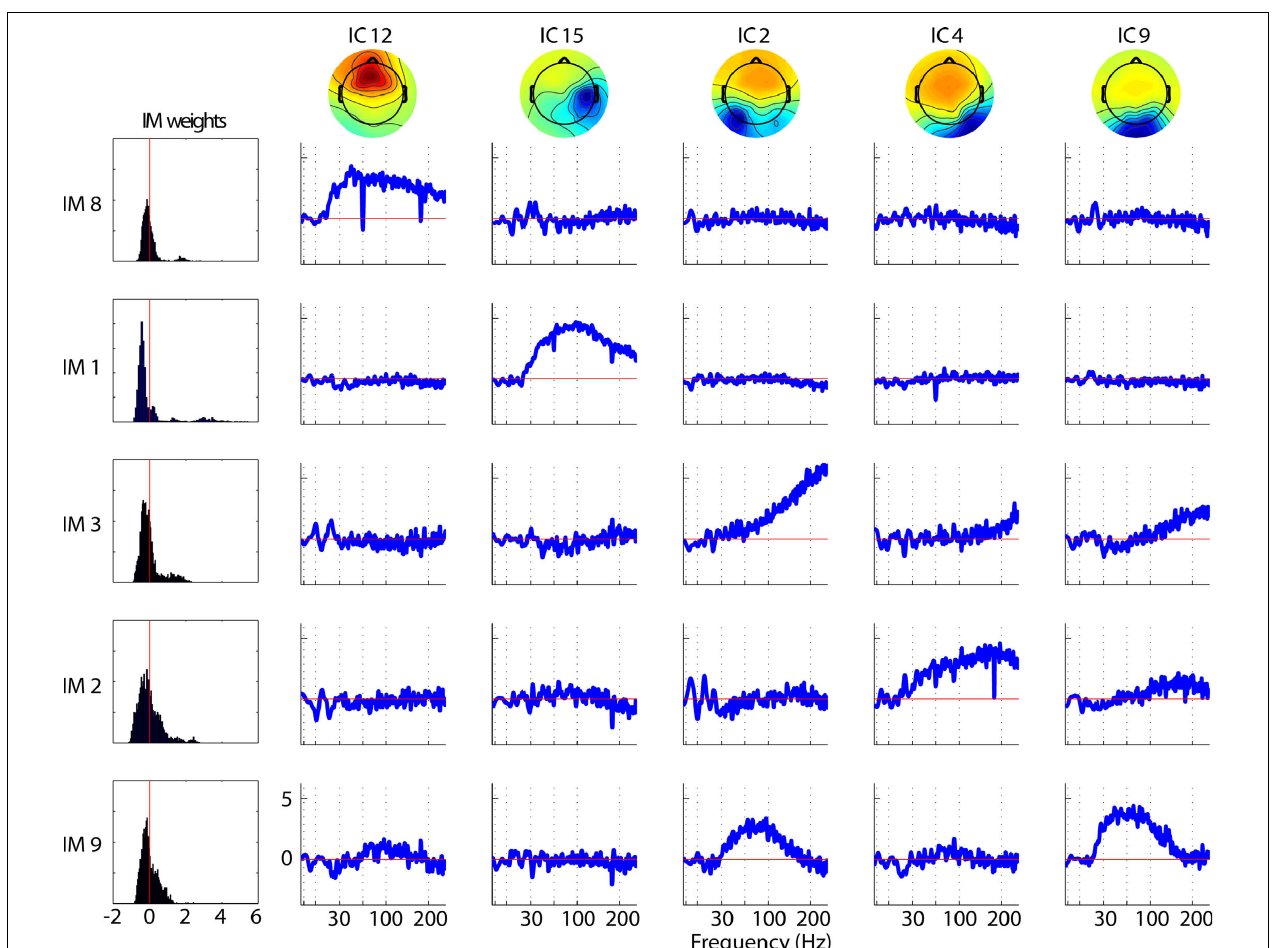
FIGURE 5 | Broadband modulators of a representative data set with higher sampling rate. This decomposition of a data set acquired with a sampling rate of 512 Hz (from a different subject than Figure 2 ) allowed an upper frequency analysis limit of 256 Hz, allowing examination of broadband patterns between